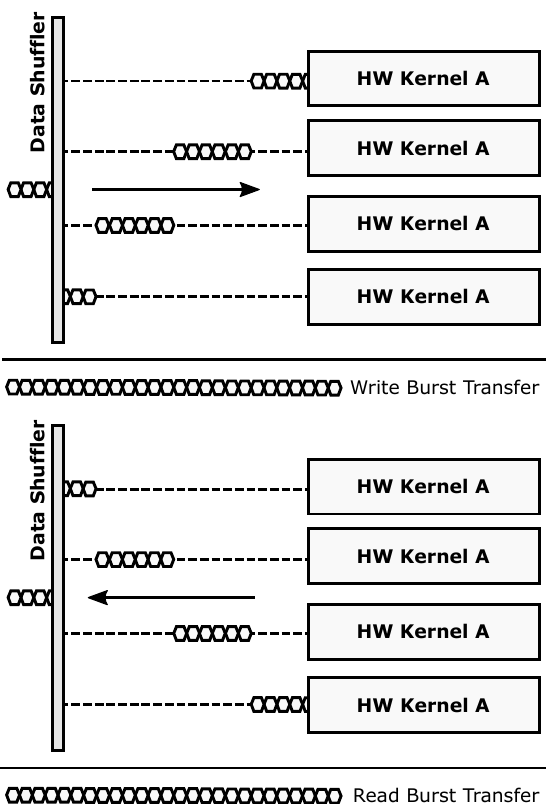
Figure 4. Parallel operation